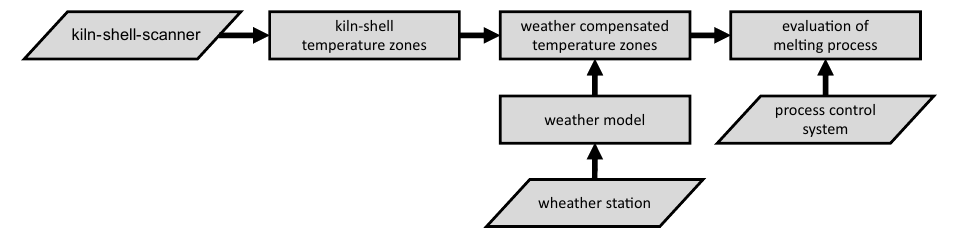
Figure 3. Flow diagram of data